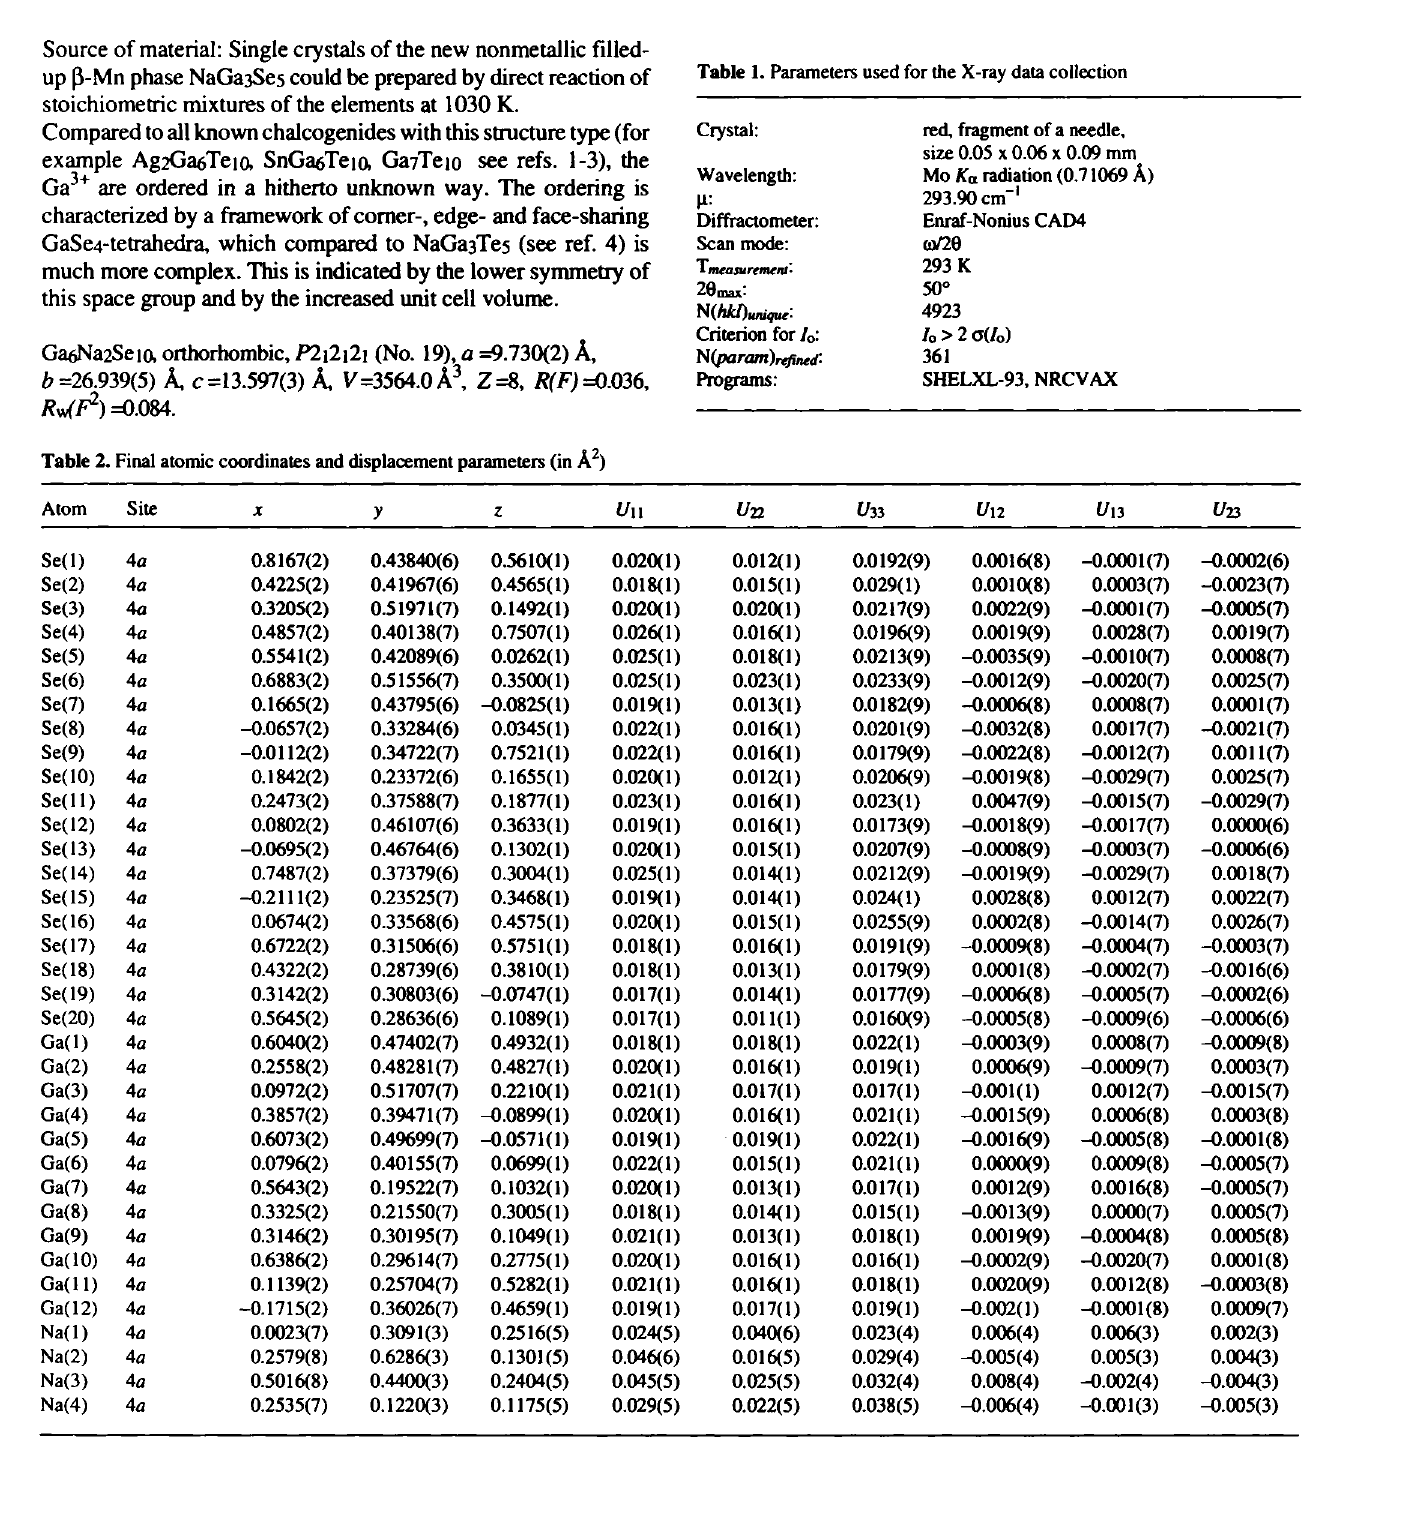
Table 1. Parameters used for the X-ray data collection